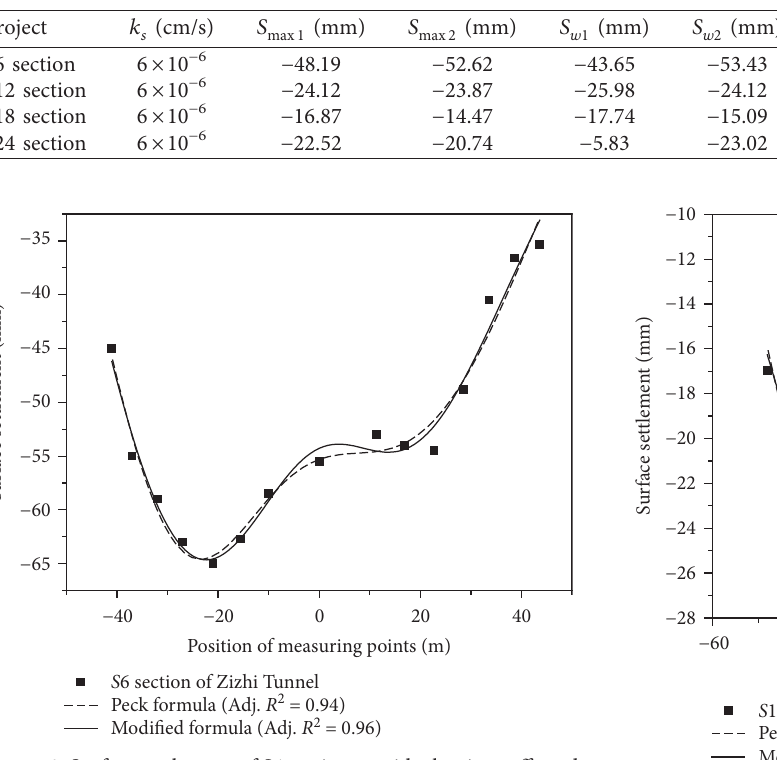
Figure 8: Surface settlement of S 6 section outside the river-affected area. Figure 9: Surface settlement of S 12 section outside the river-af- fected